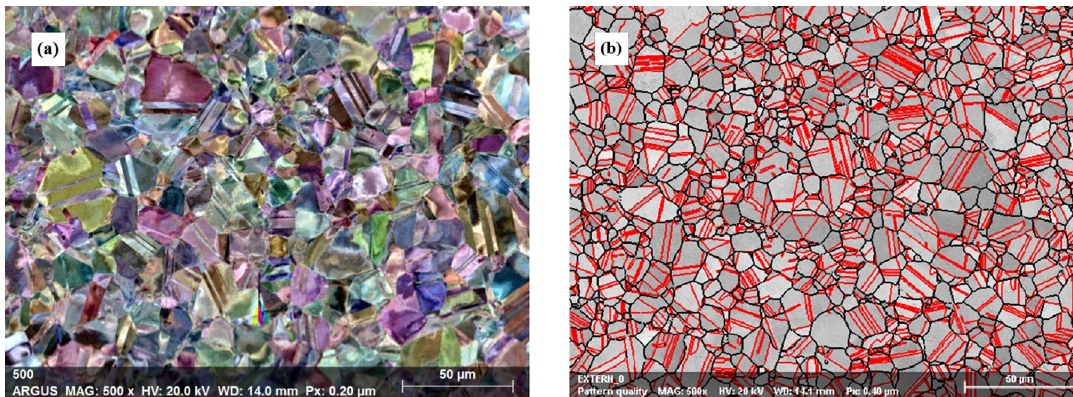
Figure 3. (a) Microstructure of Inconel 625 grains observed by EBSD/FSD. The color scale was obtained through the channeling effect, which provides an identification of the grain structure, even without metallographic attack. (b) Quality map of backscattered electron diffraction pattern with grain boundary mapping (black lines, indicating difference of orientations greater than 10º) and twin boundaries (red lines, indicating special outline Σ3, obeying the rotation orientation relationship of 60º around the <111> axis).